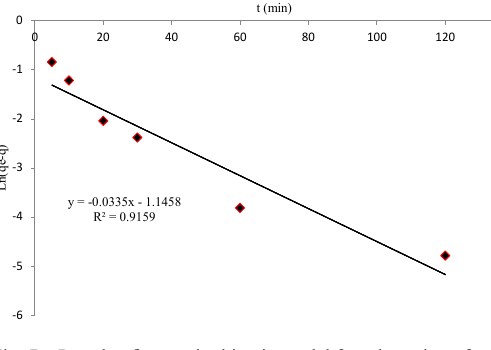
Fig.7: Pseudo–first-orderkineticmodelforadsorptionofHg(II)ontoFe 3 O 4 –Polyrhodanineat25 ◦ C Fig. 7. Pseudo– first- order kinetic model for adsorption of Hg (II) onto Fe3O4 –Polyrhodanine at 25 ◦C